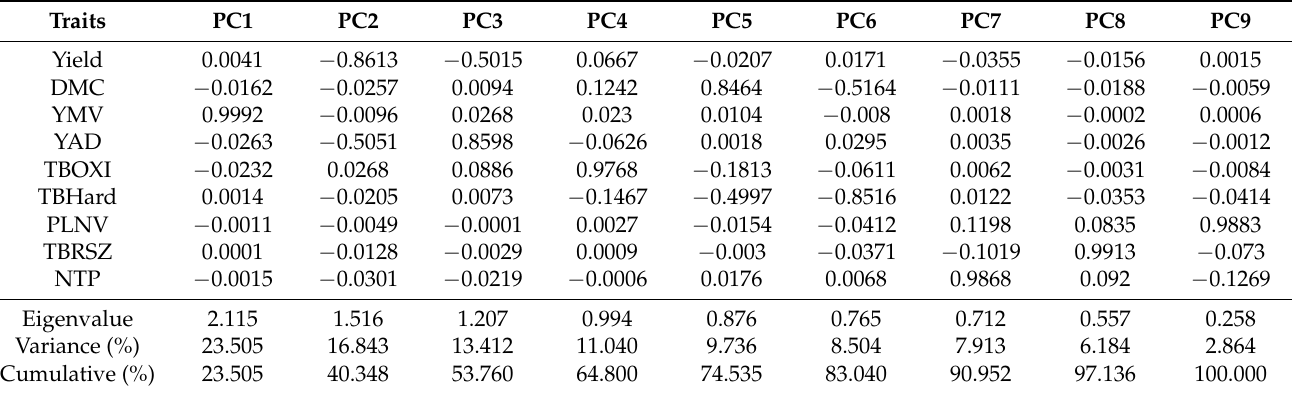
Table 4. Principal component analysis and contributions of agronomic and tuber quality traits on the variability.